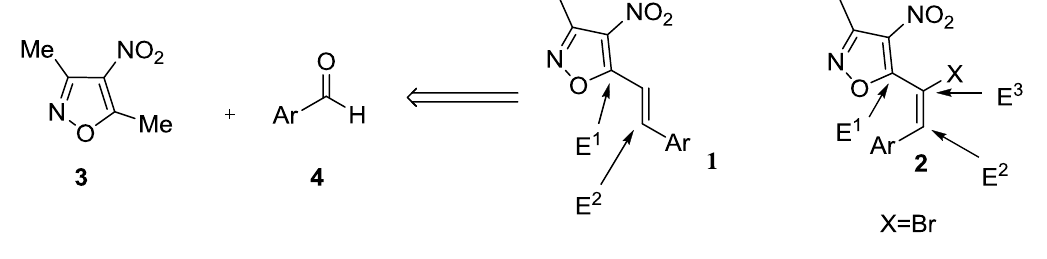
Figure 1. Polyfunctional scaffolds 1 and 2